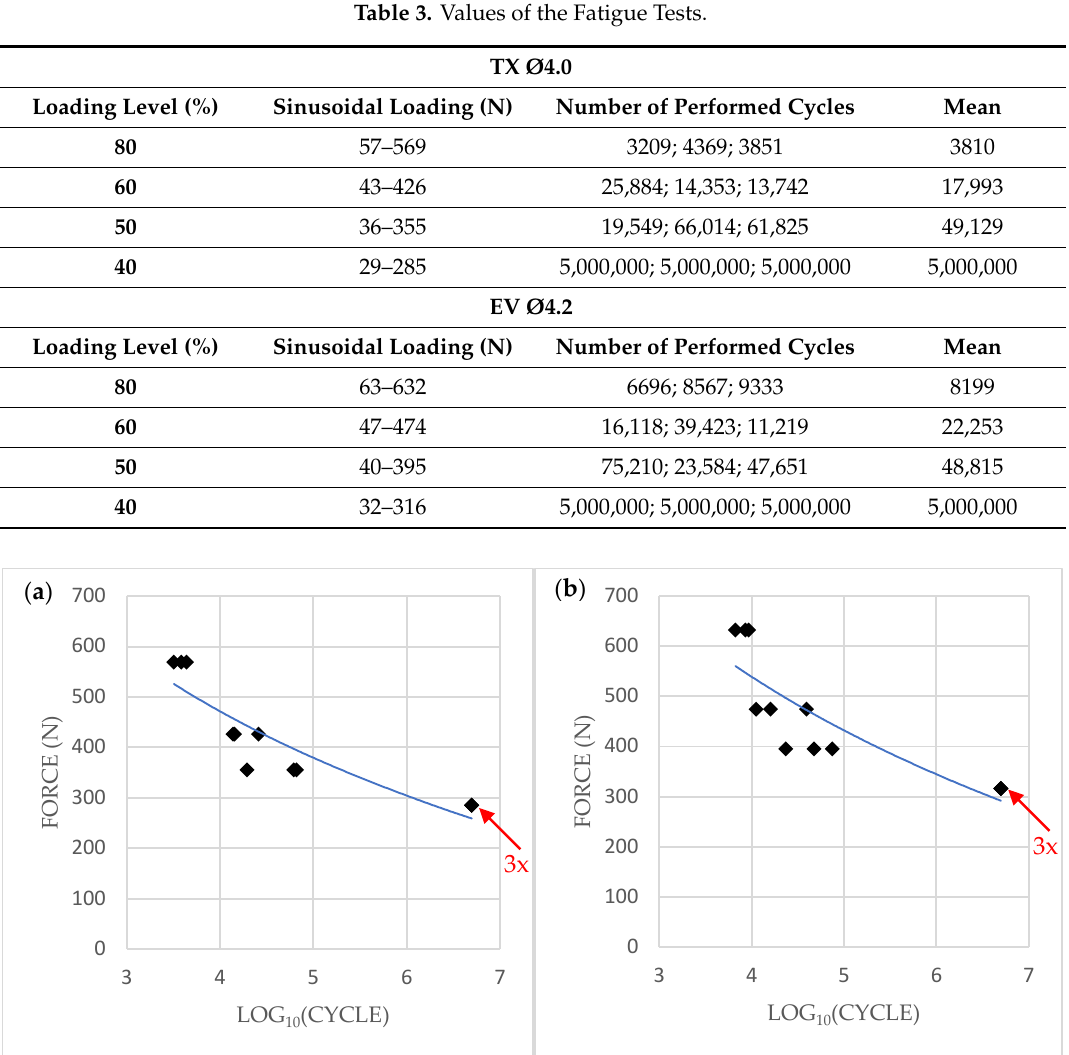
Figure 5. Plotted S / N curves from cyclic loading tests results: ( a ) TX, ( b ) EV. The x-axis represents the logarithmic value of the number of cycles performed. The loading level represents the maximum of the sinusoidal loading level; red arrow = 3 dots overlapped.